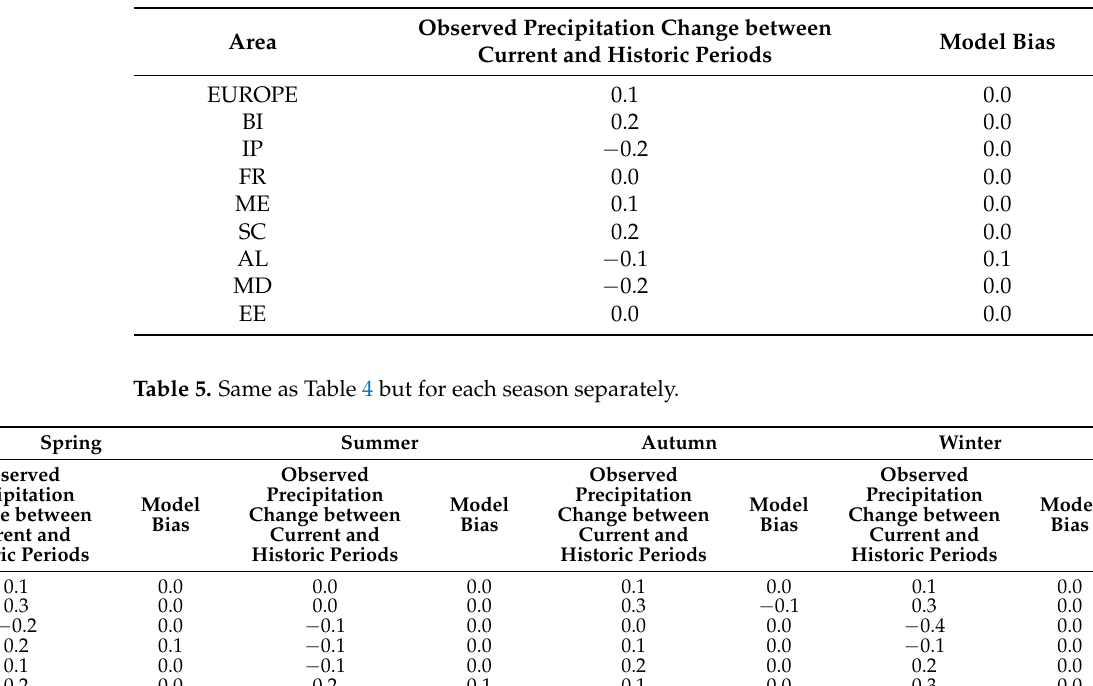
Table 4. Observed precipitation change between current (1981–2010) and historic (1951–1980) period and the model bias (E-OBS-model) for the entire European domain and the subregions examined. Units are in mm/day.